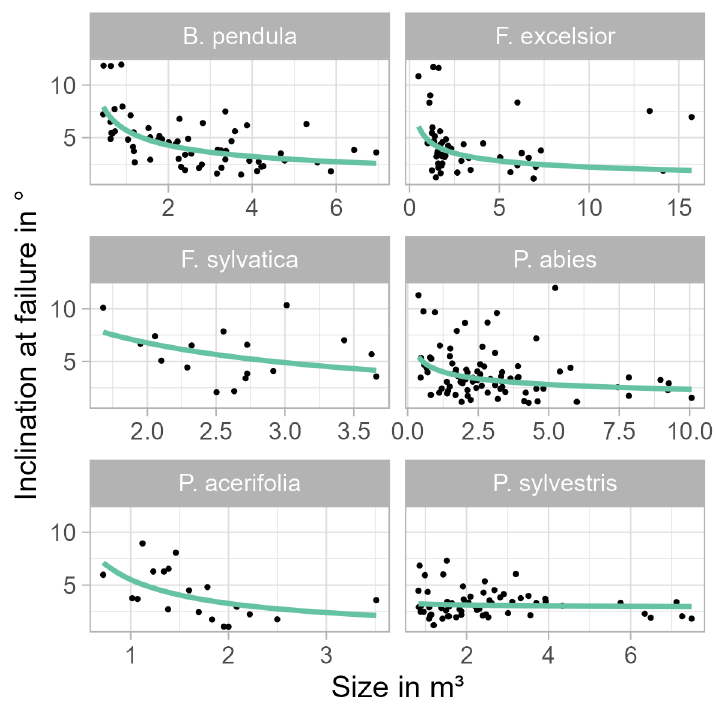
Figure 10. Basal inclination at failure, depending on tree size and species. Fitted curve: φ a = b ( d 2 h ) α [77]. ANOVA: Table